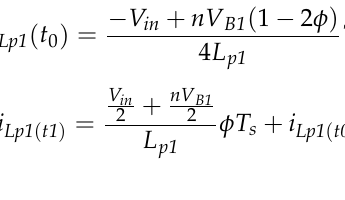
Figure 5. Operation modes of the HBDAB converter. ( a ) Mode 1 ( b ) Mode 2 ( c ) Mode 3 ( d ) Mode 4. In the steady-state of the HBDAB converter, the inductor current i Lp 1 at t 0 , t 1 , and t 2 can be derived as